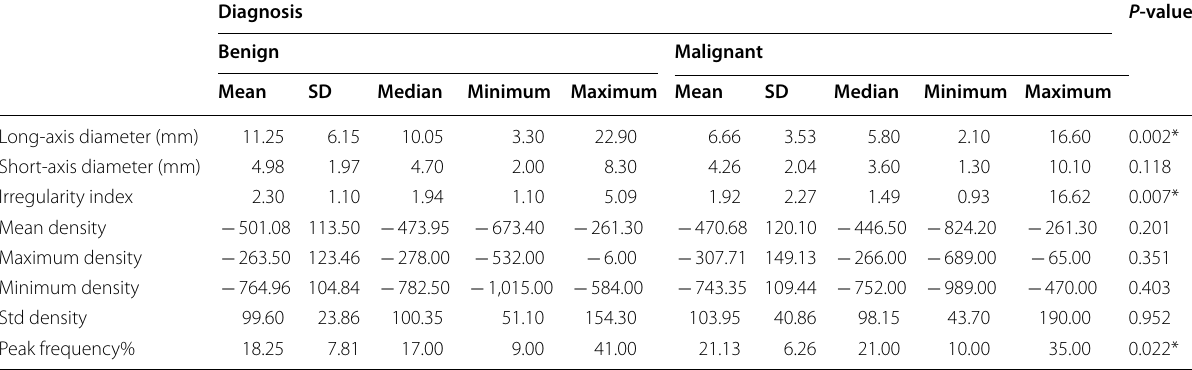
Table 2 Relation between nodule size and irregularity index in CT scan with the final